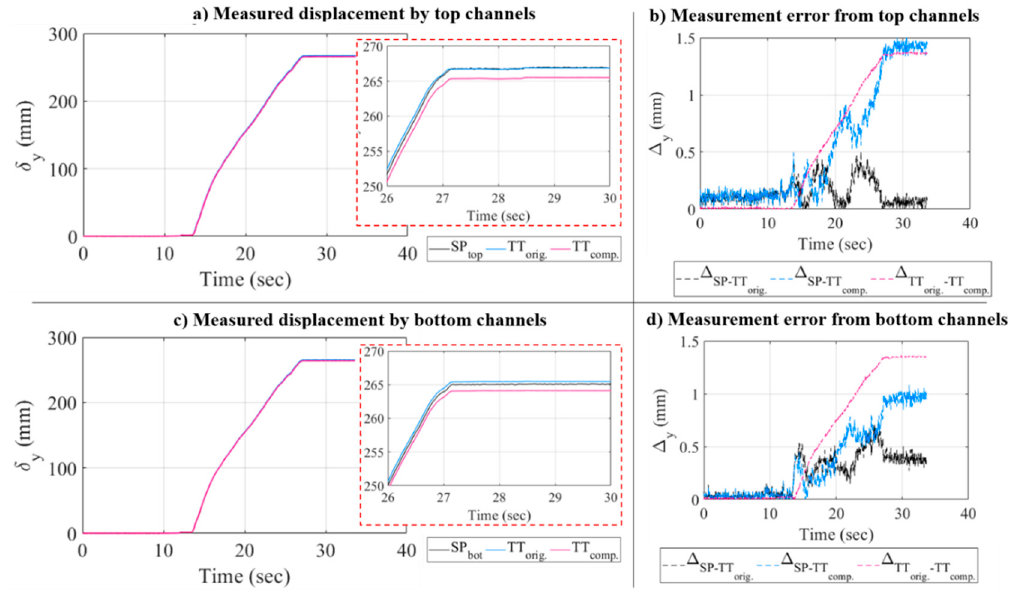
Figure 13. Comparison of measured displacement from SP and target-tracking (TT) using original and compressed images and the relative error between different measurements from quasi-static test.